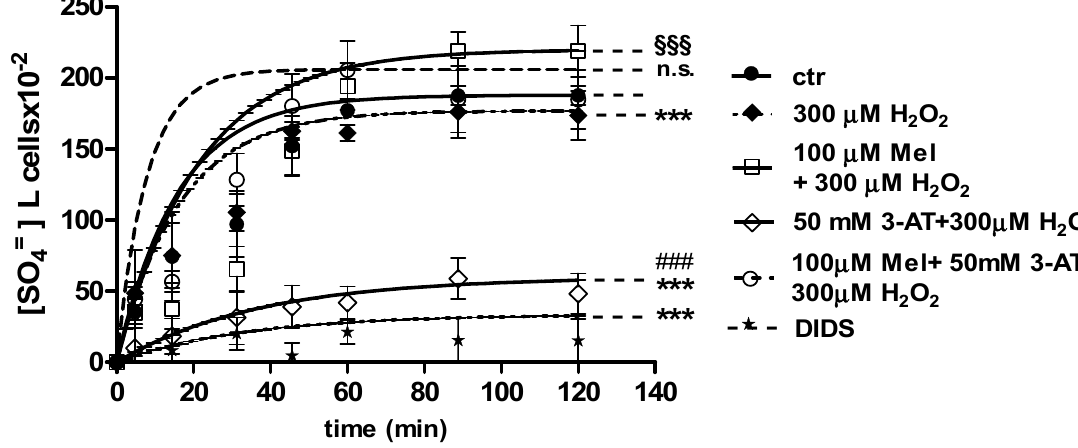
Figure 7. Time course of SO 4 = uptake measured in untreated erythrocytes (ctr) and in erythrocytes treated with 100 µ M Mel + 300 µ M H 2 O 2 with or without 50 mM 3-AT. *** p < 0.001 vs. ctr; 100 µ M Mel + 50 mM 3-AT + 300 µ M H 2 O 2 n.s. not significant vs. ctr, 100 μ M Mel + 300 μ M H 2 O 2 §§§ p < 0.001 vs. 300 µ M H 2 O 2 ; ### p < 0.001 vs. 100 µ M Mel + 50 mM 3-AT + 300 µ M H 2 O 2 as determined by one way ANOVA followed by Bonferroni’s post hoc test (N = 8).